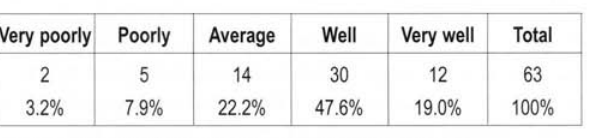
Table 10: Experiential training in year 2 as preparation for year 3 At the PAl many students (41.7%) regarded the training as 'well' and 25.0%regarded the training as 'very well'. A third of the students regarded the training as 'average'. The mean of responses was 4.25. At the HOI many students (51.3%) r egarded the training as 'well' and 15.4% regarded the training as 'very well'. The mean of responses was 3.59. A smaller proportion of students at the HOI than their counterparts regarded the training as 'very well'.